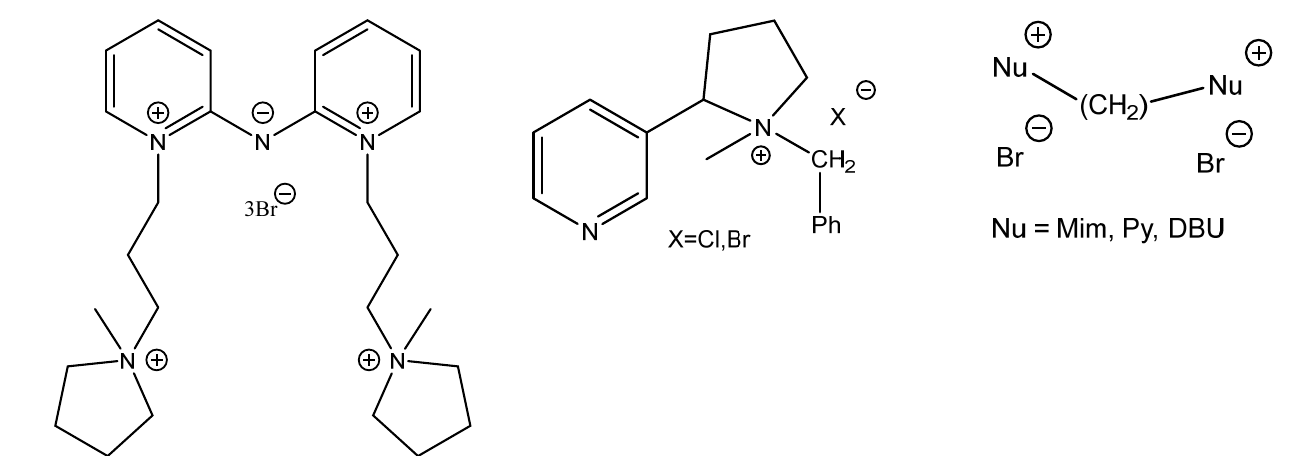
Figure 7. Structures of studied task-specific dicationic ILs (amino-pyridinium-pyrrolidinium bromide [66], Quaternized nicotine based ammonium ILs [67] and CH 2 -bridged tertiary amines [68]. Isothiouronium salts (Scheme 8) were also chosen for the testing of catalytic activity for CO 2 addition, providing encouraging results (over 90% yield with selectivity over 99%) at 2 MPa pressure of CO 2 and 140 °C after 2 h of action using 1 molar % of catalyst. The corresponding thiourea was practically nonactive [55].